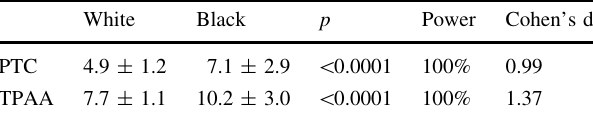
Table 2 Comparison of posterior tibial slope determined with pos- terior tibial cortex (PTC) and tibial proximal anatomical axis (TPAA) methods in white and black patients White